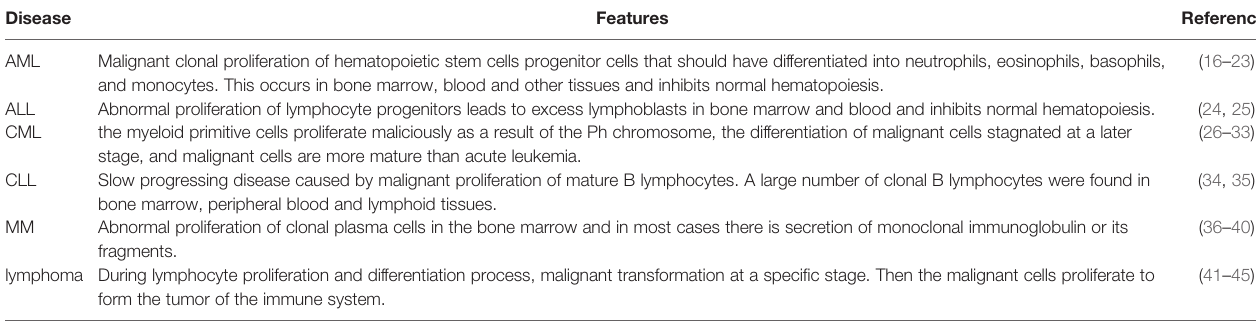
TABLE 1 | Features of various hematological malignancies present in the manuscript. Disease